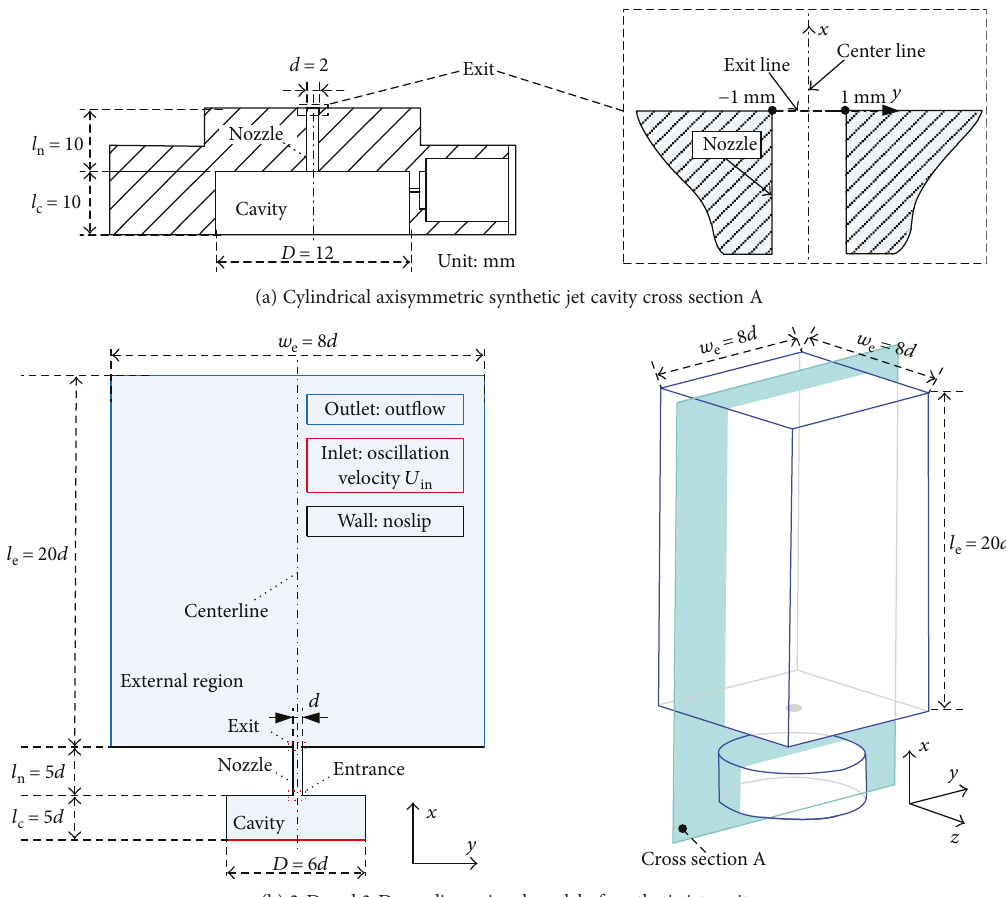
Figure 3: Numerical model of synthetic jet